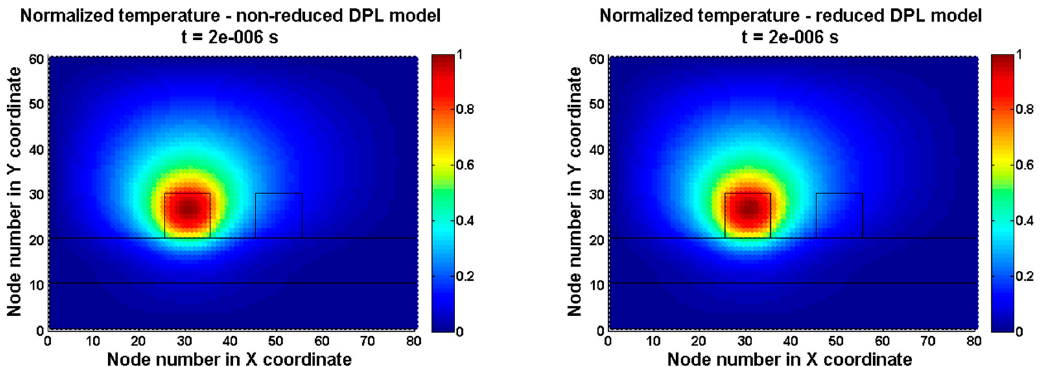
Figure 6. Comparison of normalized temperature rise in a cross-sectional area of the investigated MEMS structure obtained using reduced and non-reduced DPL model for t = 2 µs (steady state) .